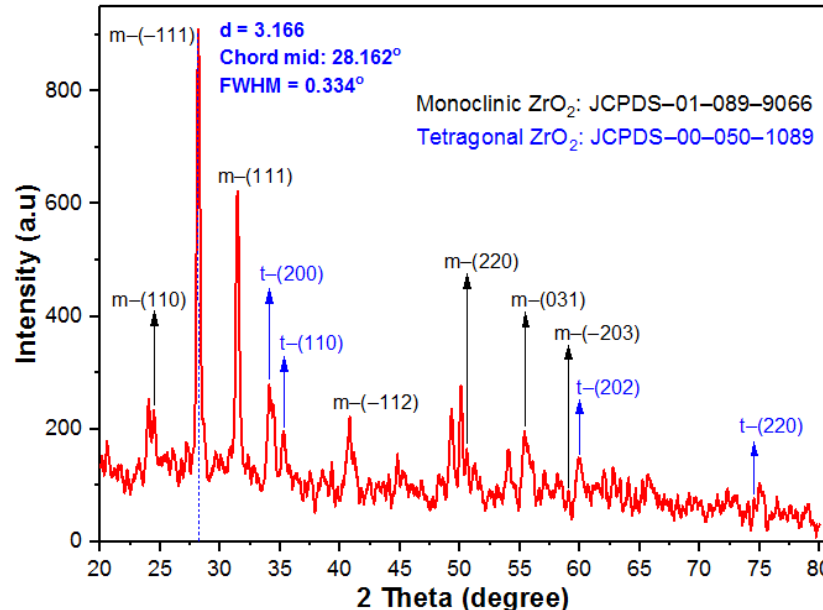
Figure 5. XRD pattern of obtained ZrO 2 after L.L.E by D2EHPA/p ‐ xylenes at 550 °C.